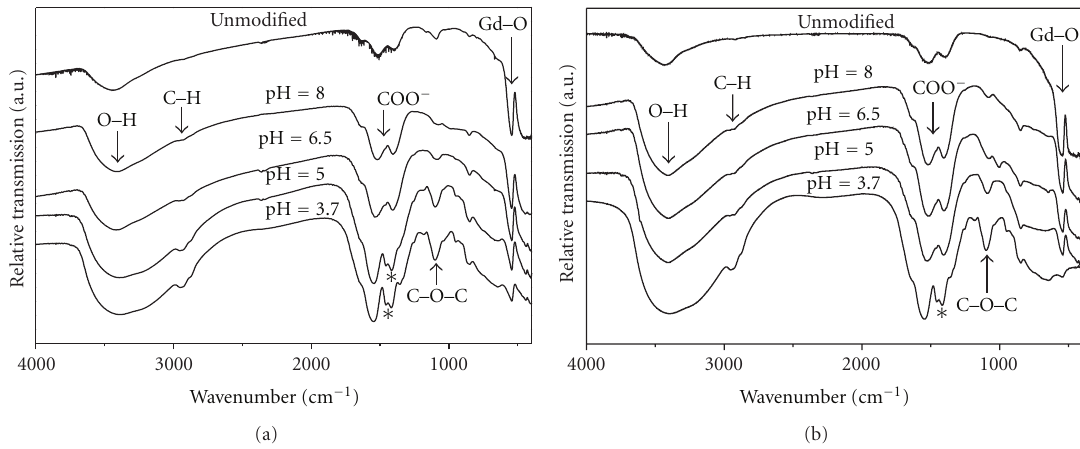
Figure 5: FT-IR spectra recorded on unmodified and PEG- b -PAAc modified (a) ParticlesHP-CTAB and (b) Rods5 showing the influence of modification